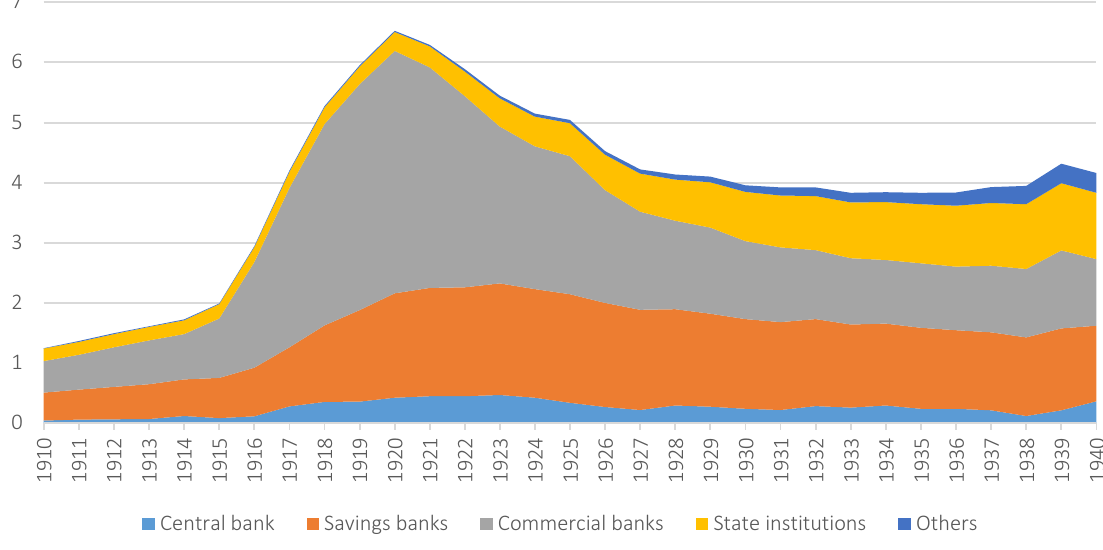
Figure 4. Norwegian domestic credit by source, in billion NOK